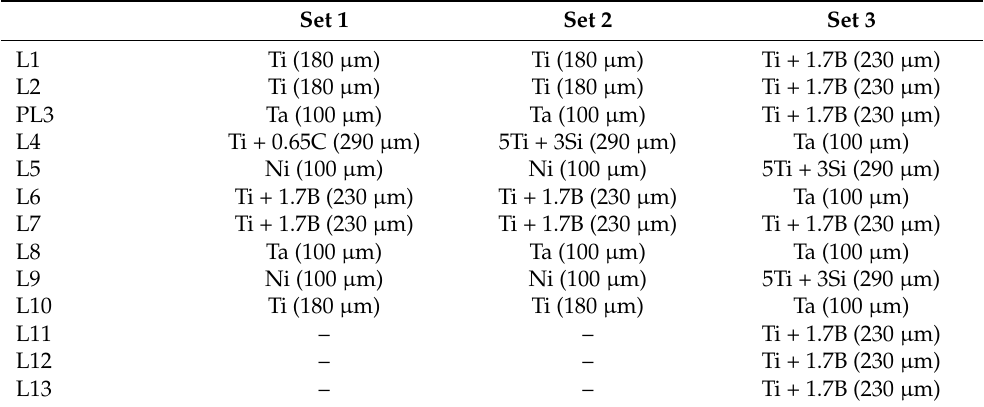
Table 2. Layer-by-layer structure of starting sandwich Sets 1 – 3 ; for the sake of brevity, layers 1–13 are presented here (and hereinafter) as